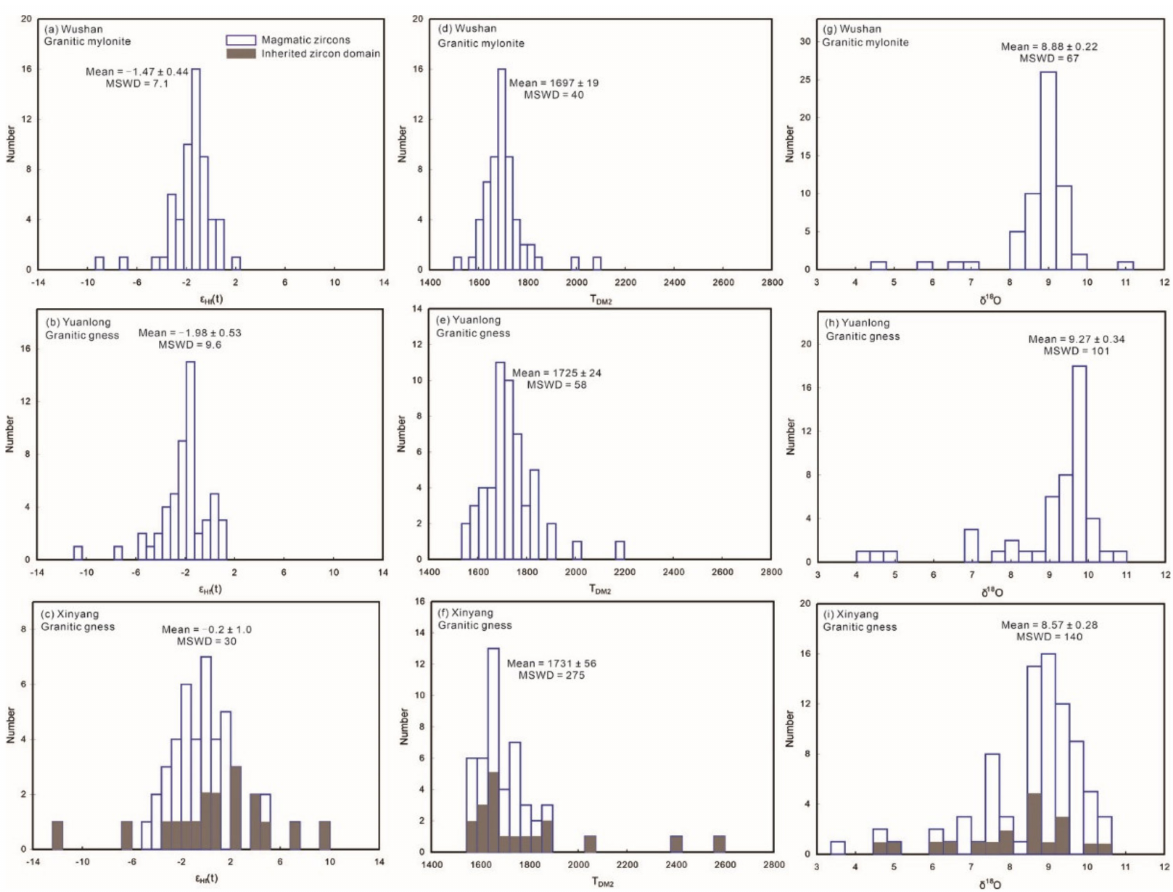
Figure 9. Histograms of the ε Hf (t), T DM2 , and δ 18 O values of zircons from the granitic mylonites from Wushan ( a – c ) and granitic gneisses from Yuanlong ( d – f ) and Xinyang ( g – i ) in the western margin of the